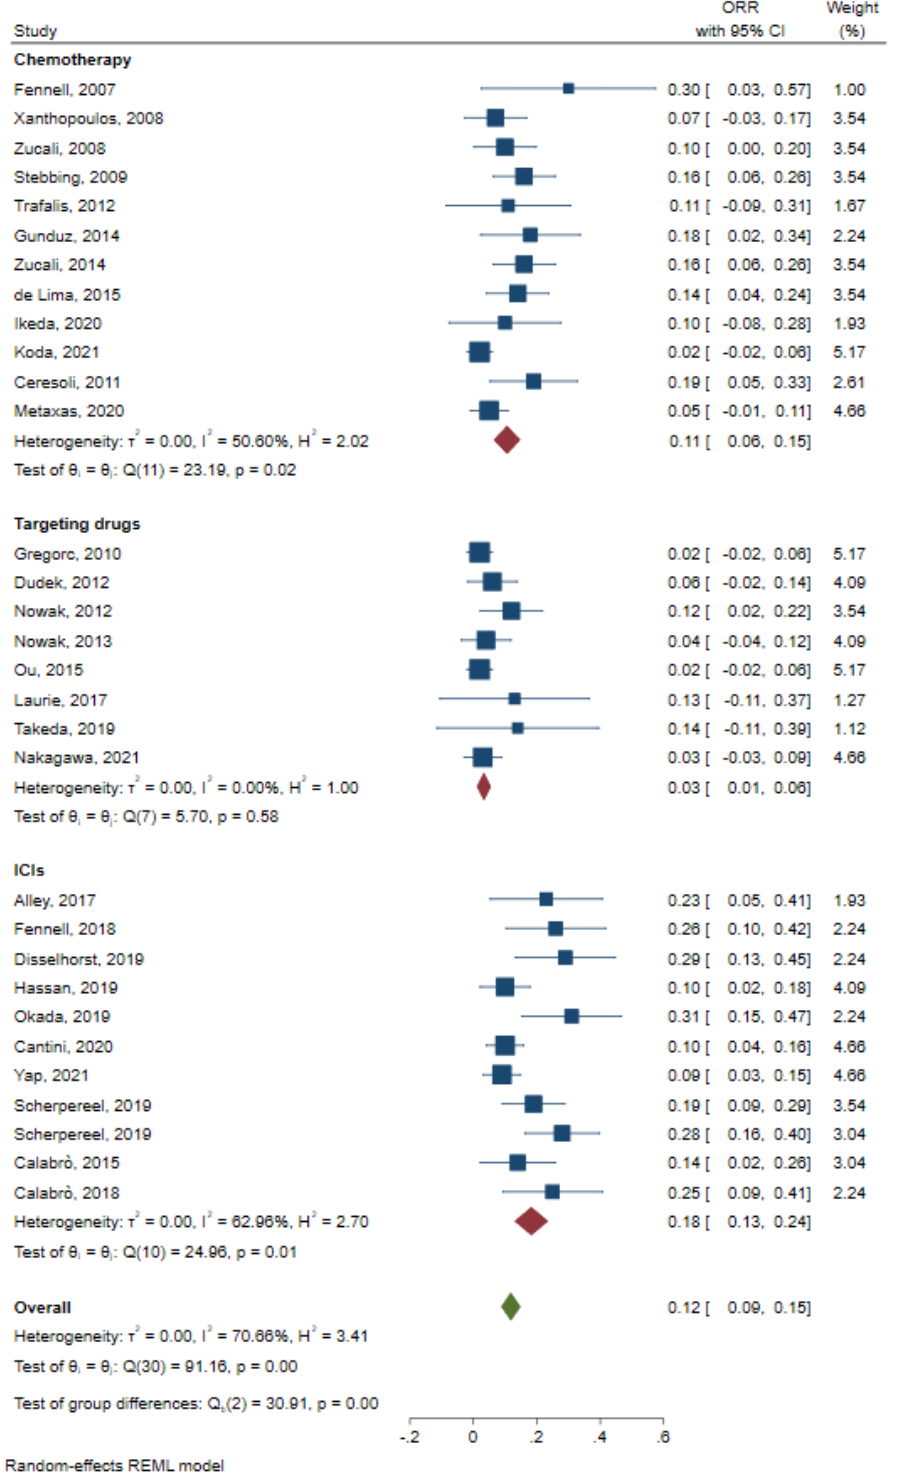
Figure 5. Pooled analysis of ORR for chemotherapy, ICIs, and targeting drugs [7,9 – 11,13,15,16,18 – 25,27,29 – 32,34 – 39,41,46,47,49] . As for SD rate, chemotherapy treatment enjoyed the best overall benefits (0.51 with 95%CI: 0.42 – 0.61, Figure 6). ICIs had the worst overall benefits (0.36 with 95%CI: 0.30 – 0.43, Figure 6).